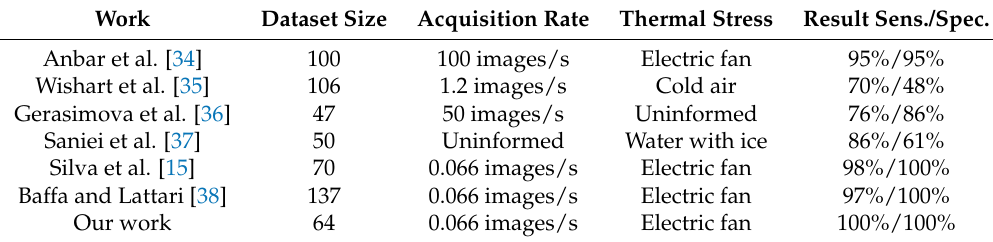
Table 6. Related work and their main